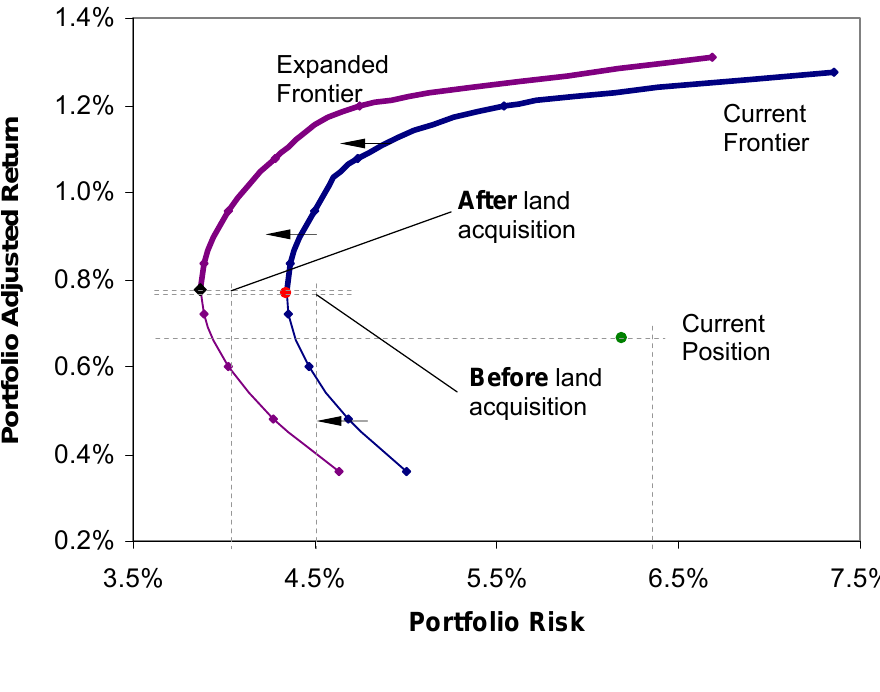
Figure 10 - Shift of the efficient